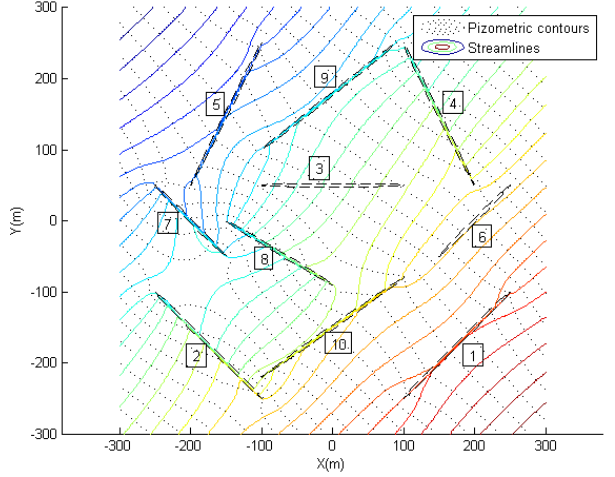
Figure 11. 10 fractures with same hydraulic conductivities and parameters given in Table 5.